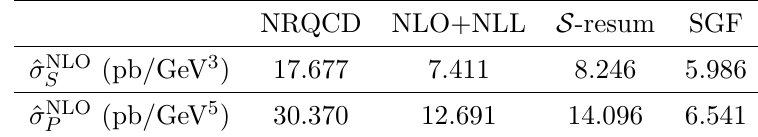
Table 1 . The coefficients of the integrated cross section in different methods.